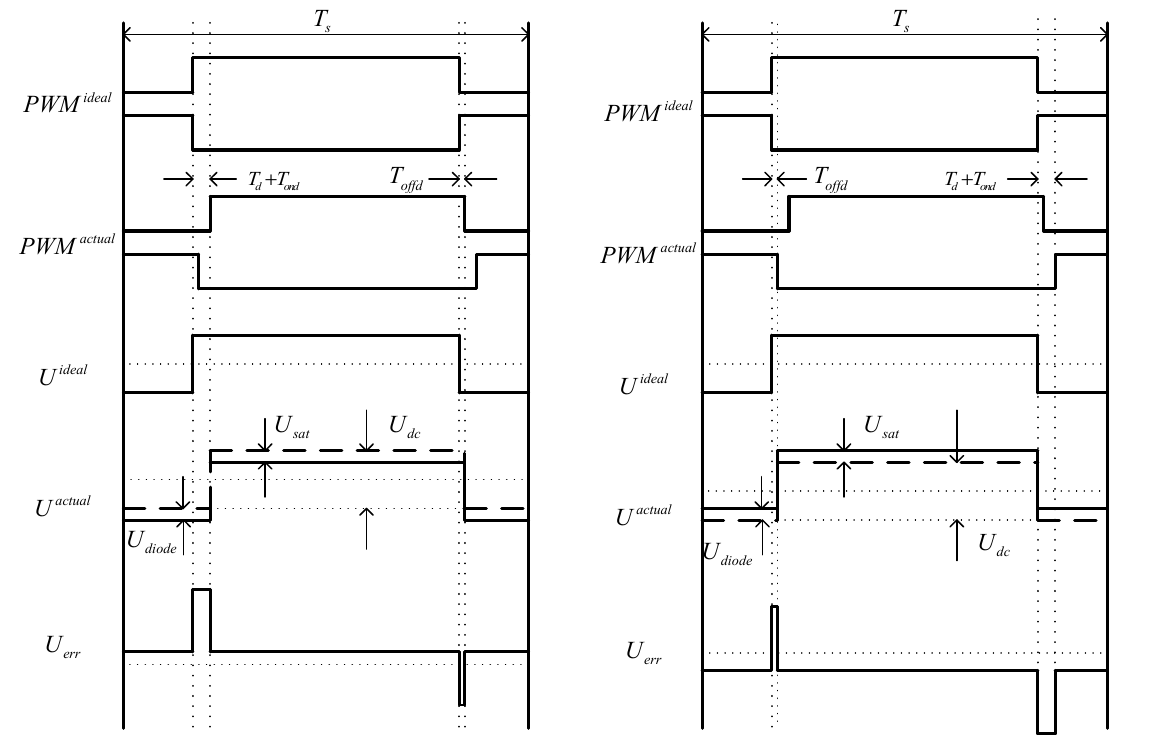
Figure 3. Phase leg of the converter during the dead-time period.